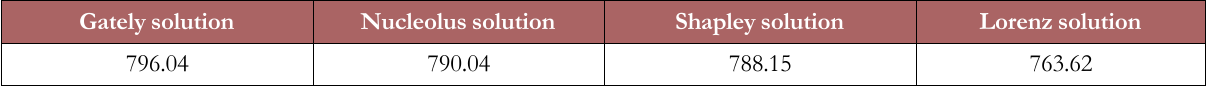
Table 5. Euclidean length of the allocations of the game-theoretic